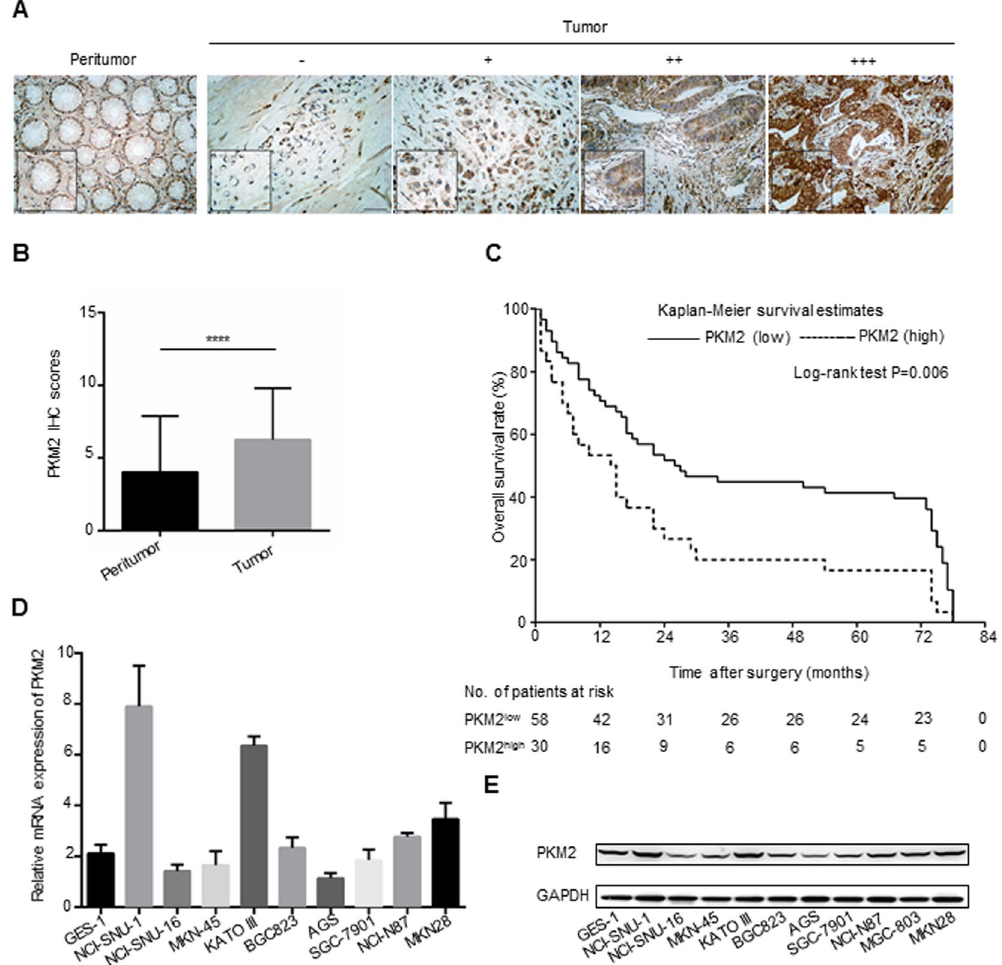
Figure 1. Expression and prognostic value of PKM2 in GC tissues (training cohort, n = 88) and expression of PKM2 in GC cell lines. ( A ) Representative images of PKM2 staining in peritumoral gastric tissues and tumor tissues of the different staining patterns are shown here and graded from 0 to +++ . Scale bar, 200 × , 100 μ m. ( B ) Analysis of the IHC scores of PKM2 expression levels in human gastric cancer tissues compared with peritumoral gastric tissues. Error bar indicated standard deviation. ( C ) Kaplan-Meier analysis of overall survival for PKM2 protein expression, and the log-rank test identified PKM2 is significantly associated with cancer specific survival in GC patients. ( D ) Quantitative RT-PCR analysis of PKM2 mRNA levels in 10 GC cells and normal gastric epithelial cell line GES-1; GAPDH was used as a loading control. ( E ) Western blot analysis of PKM2 protein levels in 10 GC cells and normal gastric epithelial cell line GES-1. Full-length gels and blots are presented in the Supplementary files 2; GAPDH was used as a loading control. Data were shown as mean ( ± SD) from three independent experiments. **** P <